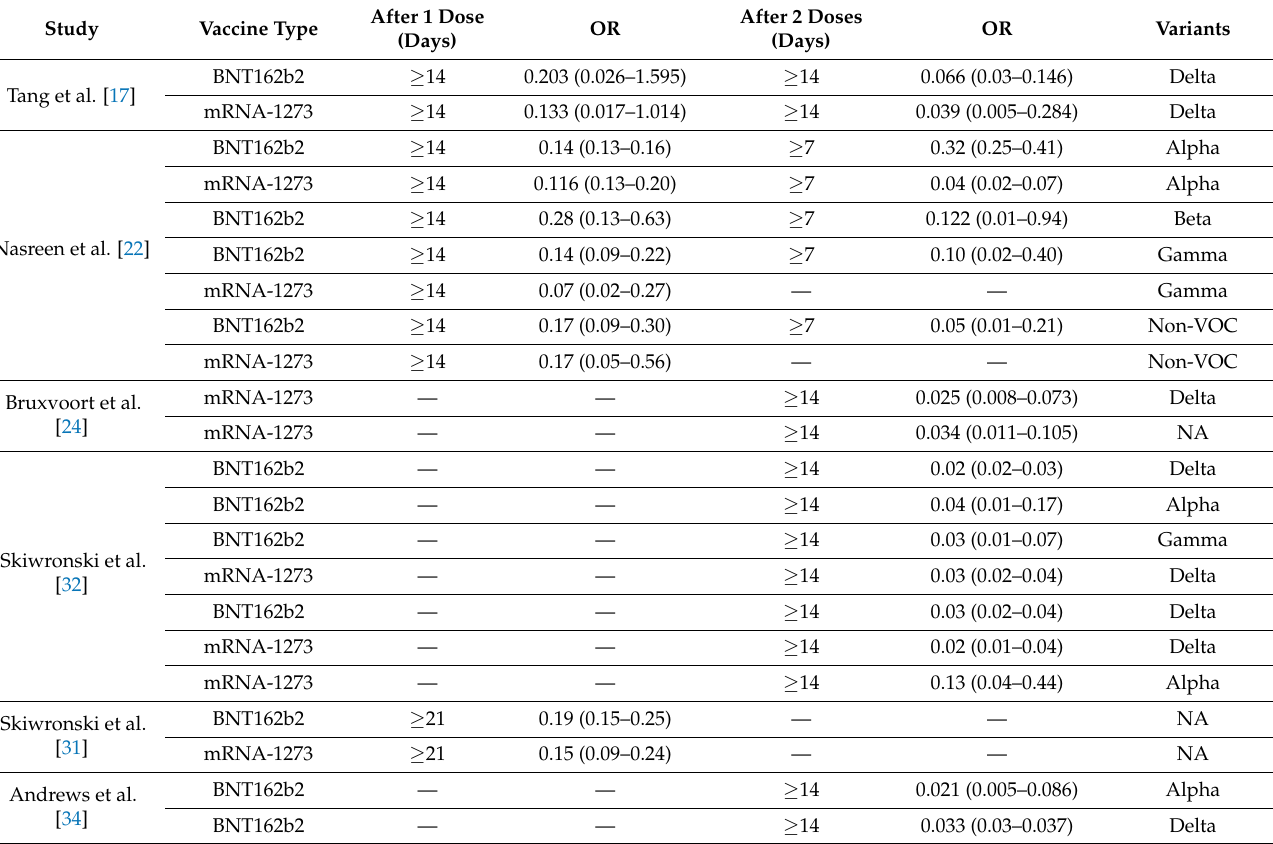
Table A3. Effectiveness of vaccines against COVID-19 hospitalization after 1 dose and after 2